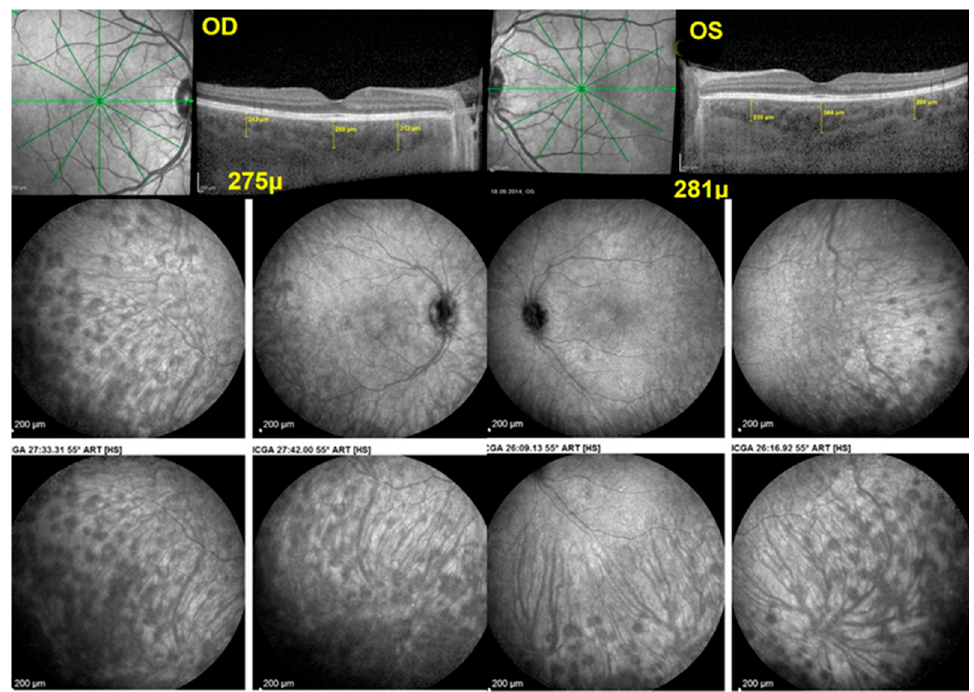
Figure 7. ICGA of Vogt–Koyanagi–Harada disease showing only peripheral lesions. After 6 months of triple immunosuppressive treatment, the patient still complained of headaches. FA and EDI ‐ OCT were normal, and ICGA showed remaining lesions only present in the periphery out of the scope of OCT ‐ A.